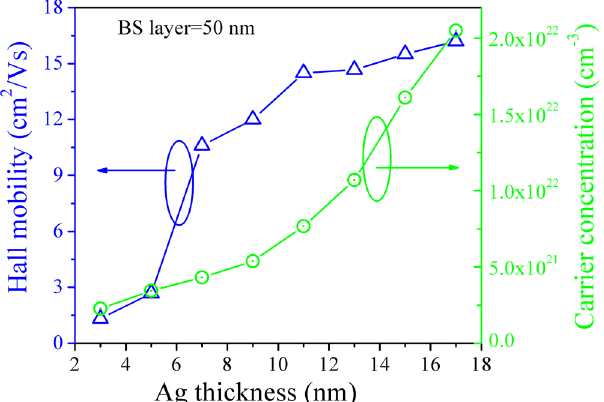
Figure 3. Hall mobility and carrier concentration of the BS/Ag/BS multilayer flexible thin films as a function of Ag